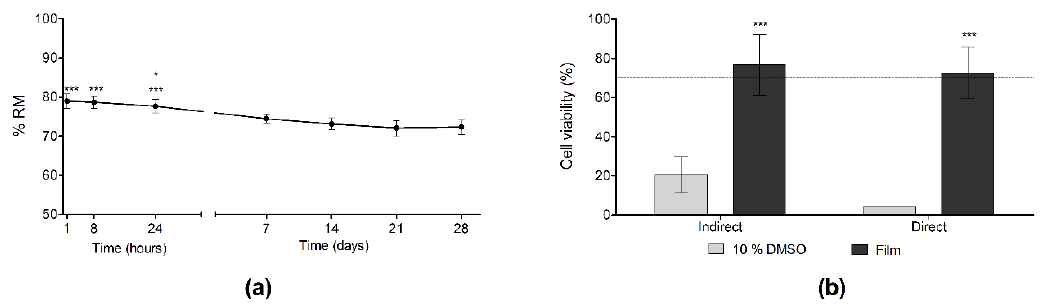
Figure 10. ( a ) Hydrolytic degradation. *** p < 0.001 comparing results at 1 h, 8 h and 24 h time points with the remaining time points, except from the comparison between 24 h and 7 days, when the statistical difference was lower (* p < 0.05), and ( b ) cell biocompatibility. *** p > 0.001 comparing the films with the negative control (10% DMSO).